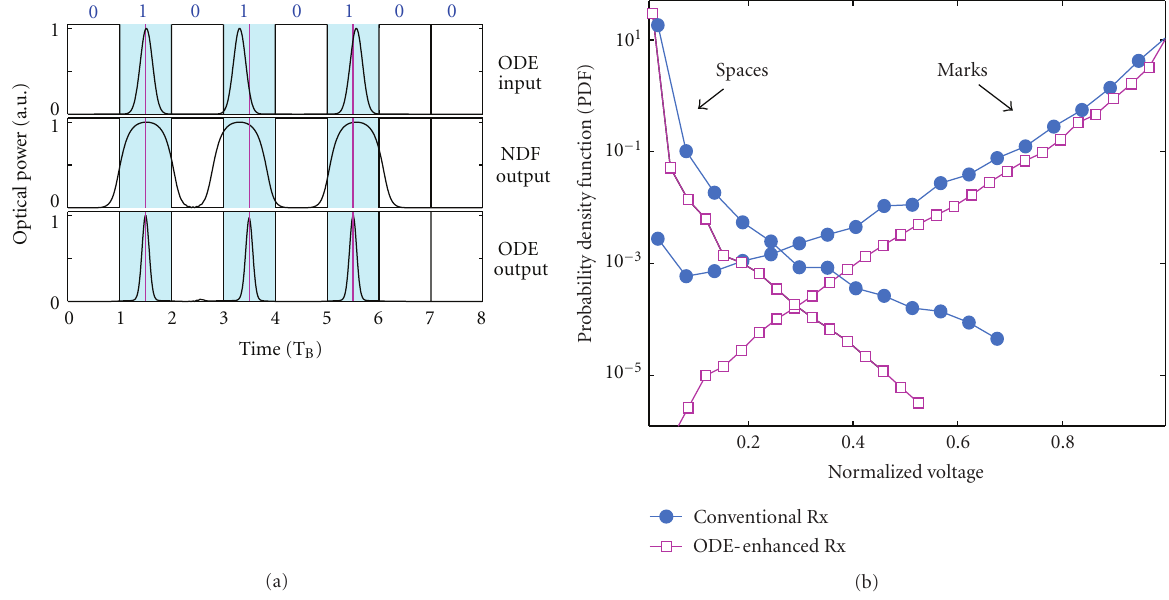
Figure 7: (a) Schematic illustration of the optical decision at an ODE-enhanced receiver. (b) Numerically calculated probability density functions for the voltage of the marks and spaces in the conventional and ODE-enhanced receivers for a 40Gbit/s RZ input signal with a random jitter of the pulse temporal position. Results adapted from